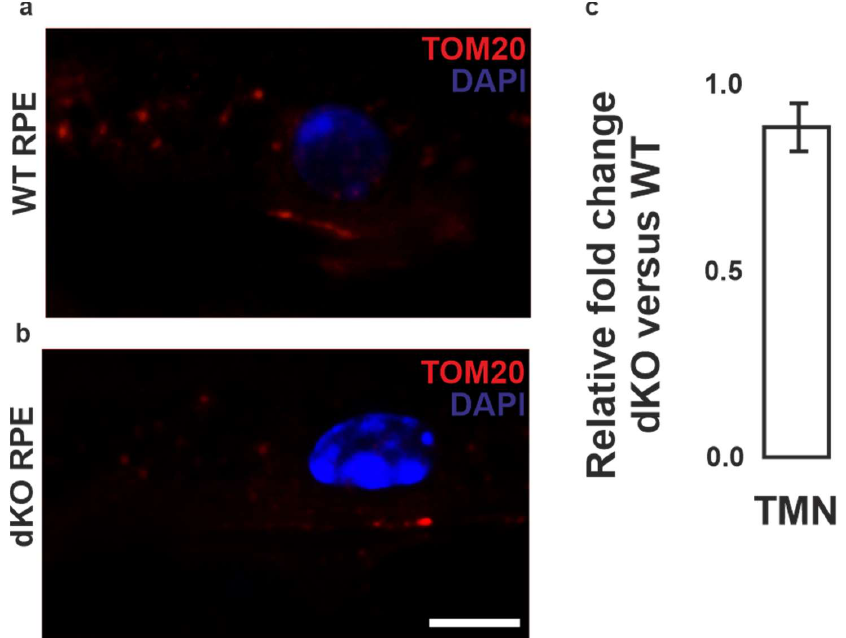
Figure 2. Confocal microscopy analysis of mitochondria in RPE cells. Mitochondrial marker TOM20 (red) binds to OMM of both healthy and damaged mitochondria in RPE cells of wild type (WT) ( a ) and double knockout (dKO) mice ( b ). The relative changes of the total mitochondrial number in dKO versus WT are shown, n = 5 images per eye/animal ( c ). Scale = 5 µm. TMN, total mitochondrial number.